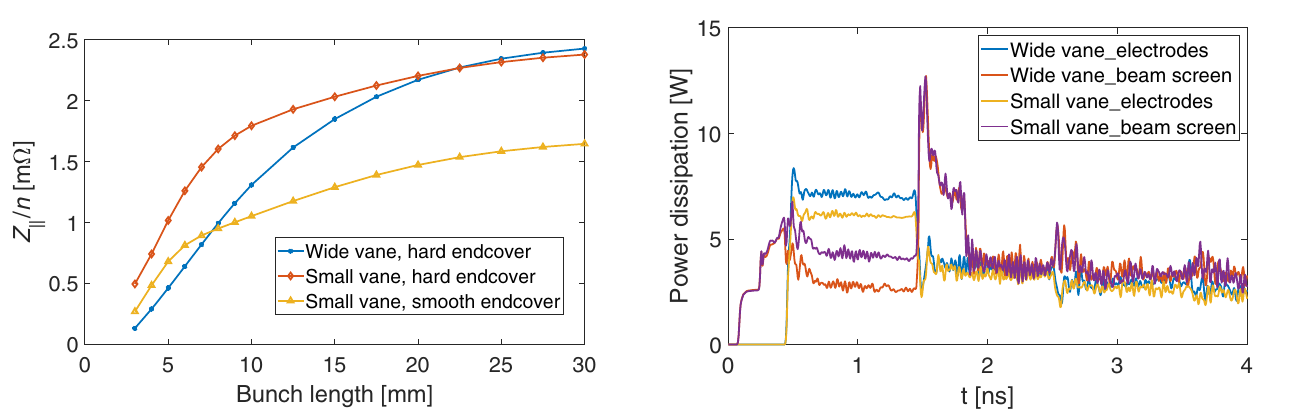
FIG. 9. Power dissipation on the electrodes and the beam screen during the bunch passage with bunch charge of 1